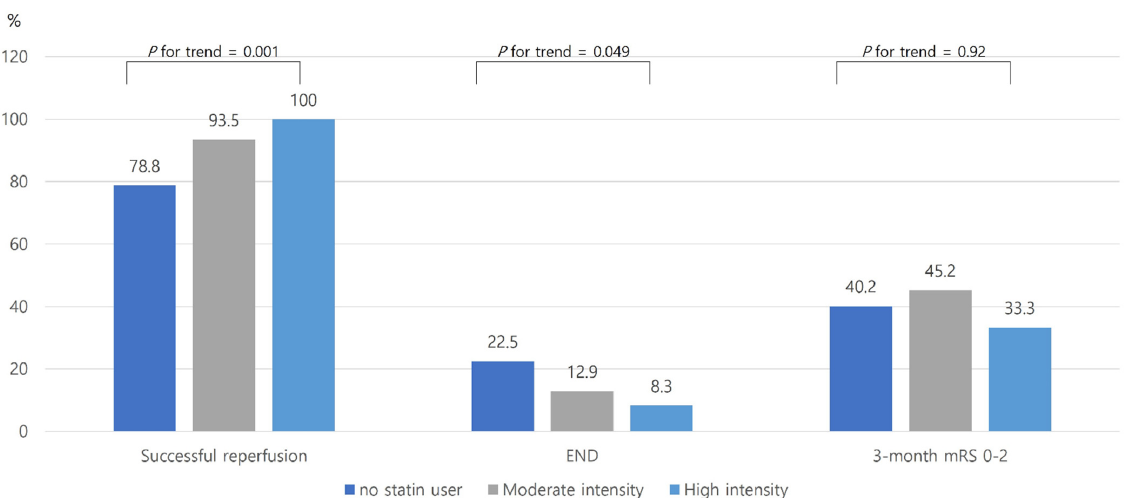
Figure 2. The proportion of outcomes according to the intensity of statins. Abbreviations: END, early neurologic deterio- ration; mRS, modified Rankin Scale.